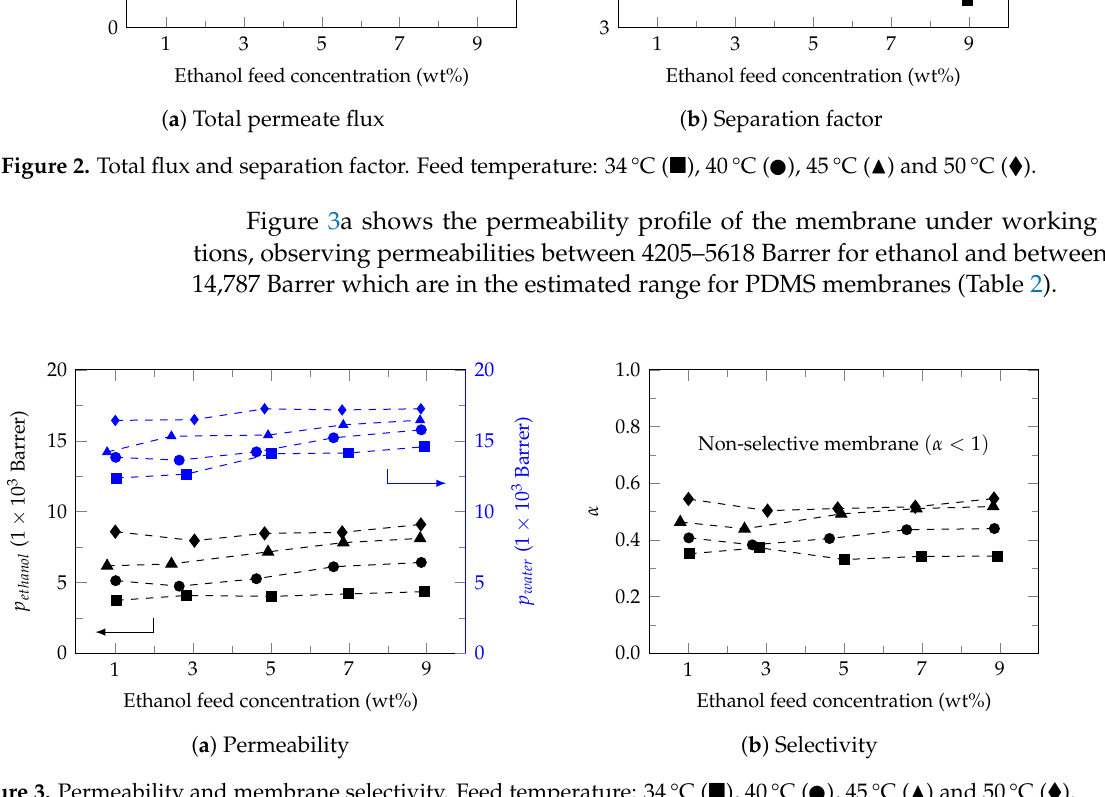
Figure 3. Permeability and membrane selectivity. Feed temperature: 34°C ( (cid:4) ), 40°C (